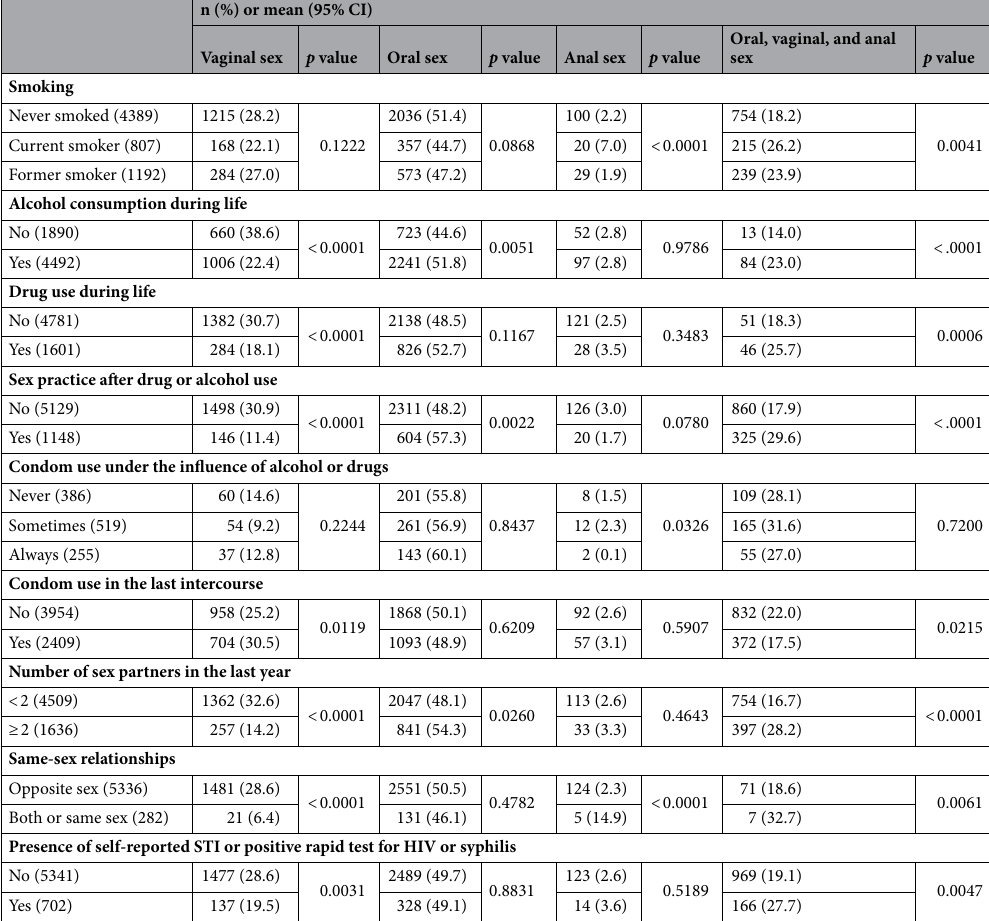
Table 2. Distribution of behavioral characteristics of the studied population, according to types of sex practices (n =